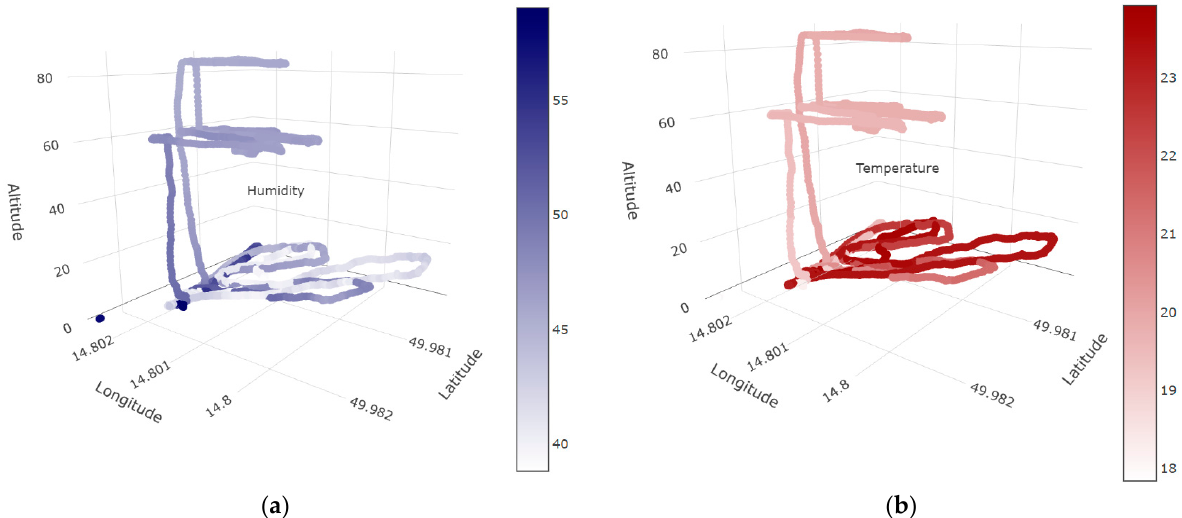
Figure 6. 3D models present the humidity ( a ) and temperature ( b ) measured by the sensor during the entire field experiment.